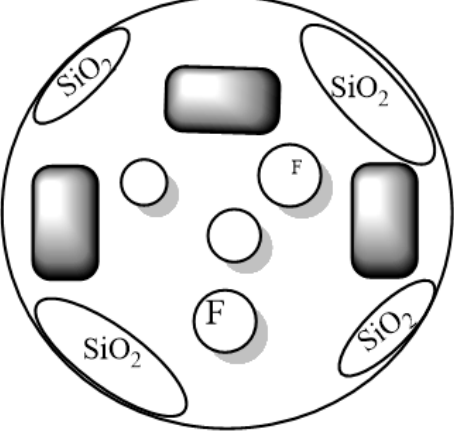
Figure 4. Schematic fly ash particle showing major components on their surface.